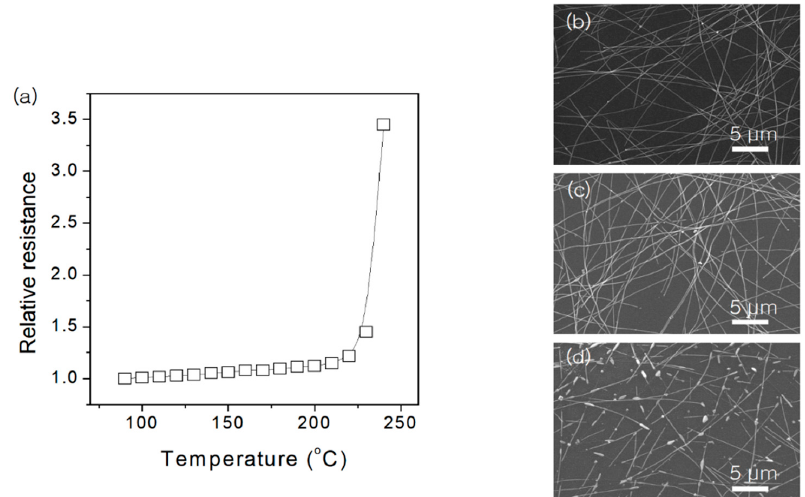
Figure 2. ( a ) Variation of the electrical resistance of Ag NW network during thermal annealing in air running from room temperature to 240 ◦ C with a heating ramp rate of 5 ◦ C / min. Morphologies of the Ag NWs after the 10-min heat treatment at ( b ) 130 ◦ C, ( c ) 170 ◦ C, and ( d ) 200 ◦ C.